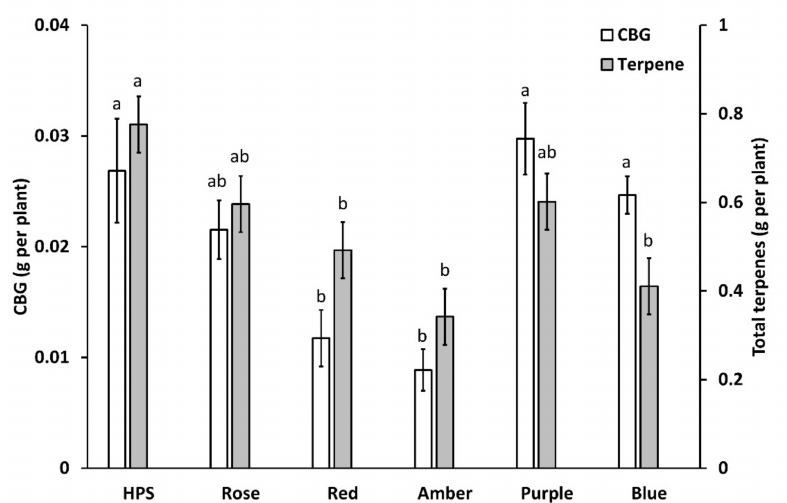
Figure 5. Effect of light treatment on CBG and total terpene yield. Treatments are high-pressure sodium (HPS), rose (430 + 630 nm, B:R ratio 1:10), red (630 nm), amber (595 nm), purple (430 + 630 nm, B:R ratio 2:1), and blue (430 nm). Values presented in mean ± SE ( n = 3). Different letters (a, b) above the bars represent a significant difference between treatments by Tukey HSD ( p <